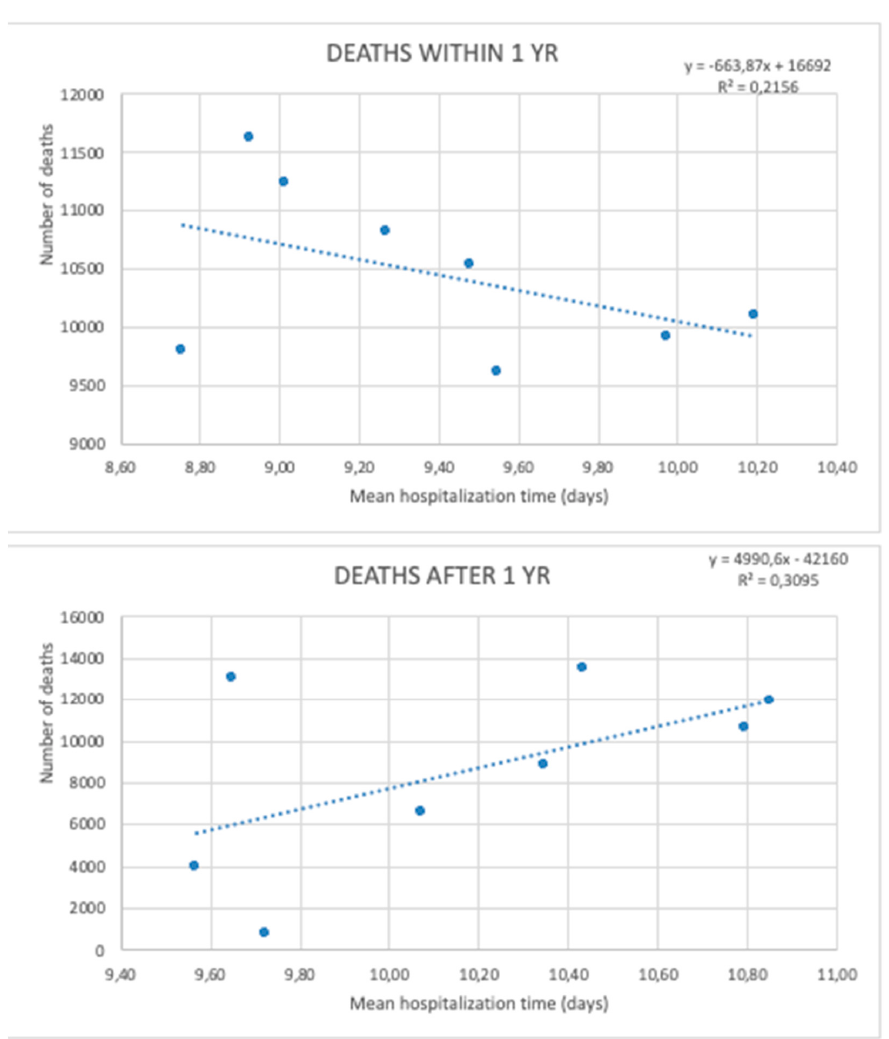
Figure 11. Regression models comparing hospitalization time and the number of deaths within and after one year following HF (hip fracture) during the study period.